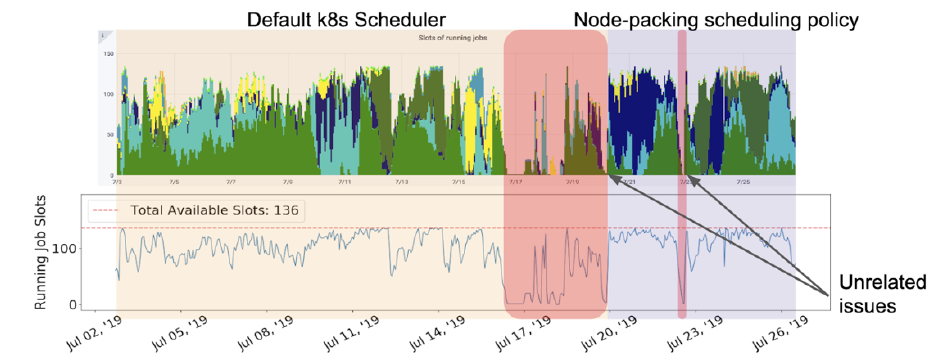
Fig. 4. Default Kubernetes scheduling vs node packing scheduling on the UVic test cluster